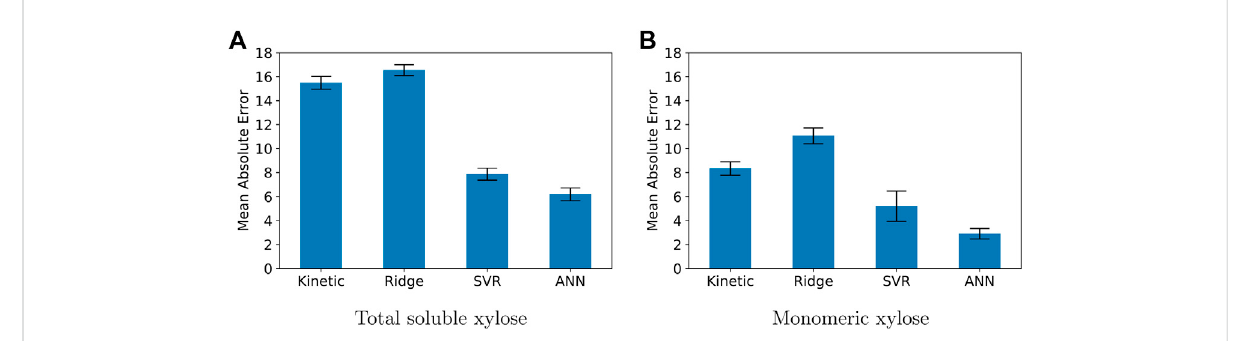
FIGURE 3 Comparison of different computational methods in terms of mean absolute error of test data for: (A) total soluble xylose yield and (B) monomeric xylose yield. Mean absolute error was determined from fi ve replicates of the computational experiment. Its units are percentage points of